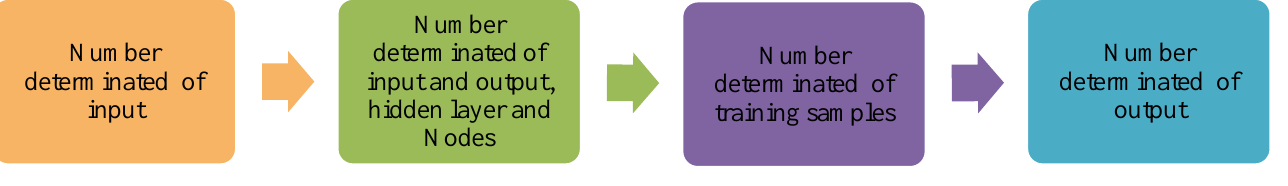
Figure 6: BP network design